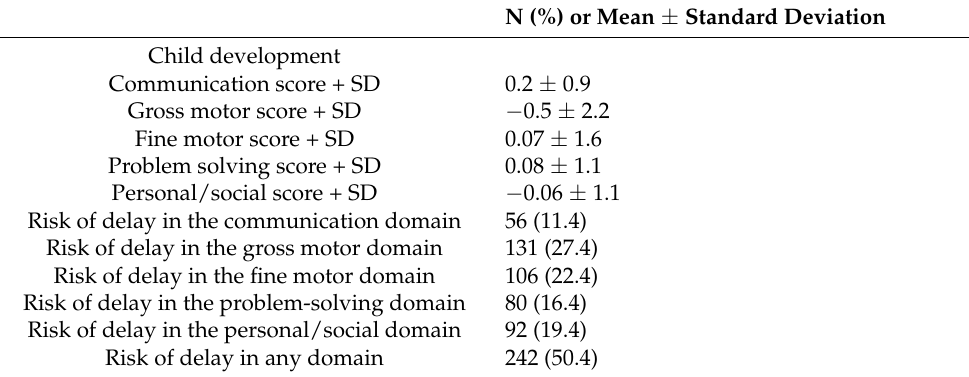
Table 2. Description of the results of the assessment of child development